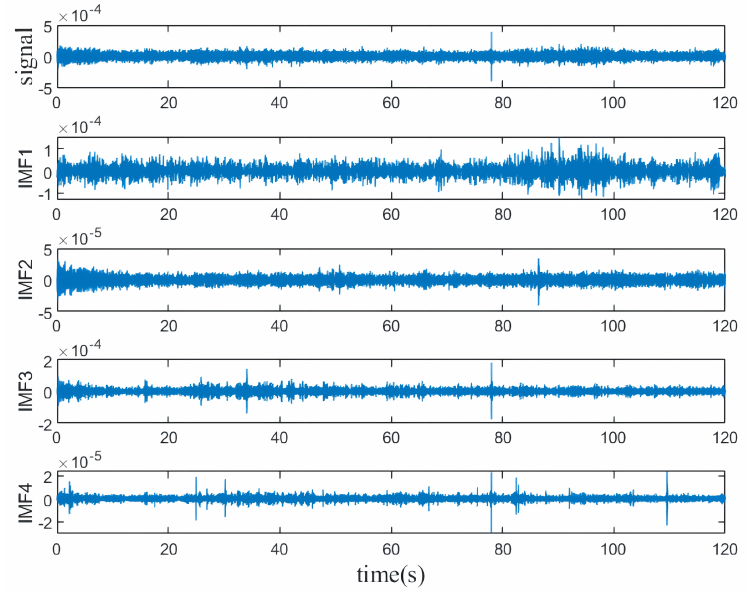
Figure 4. IMF Component of acceleration signal based on VMD algorithm.